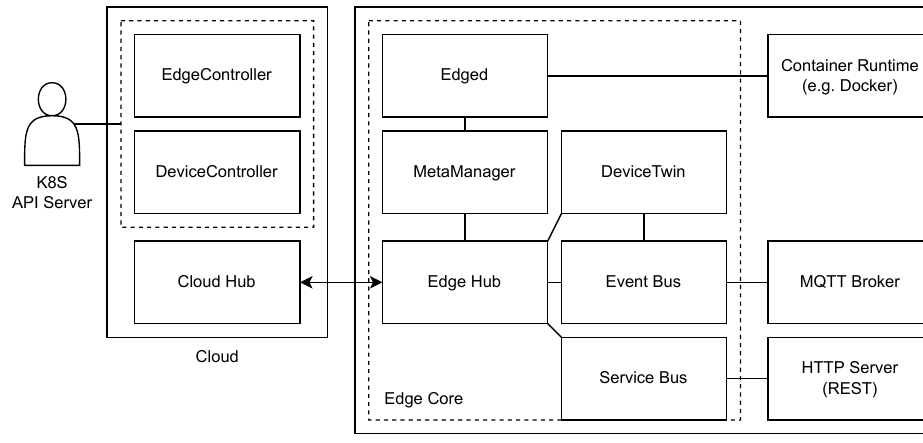
Figure 4. KubeEdge